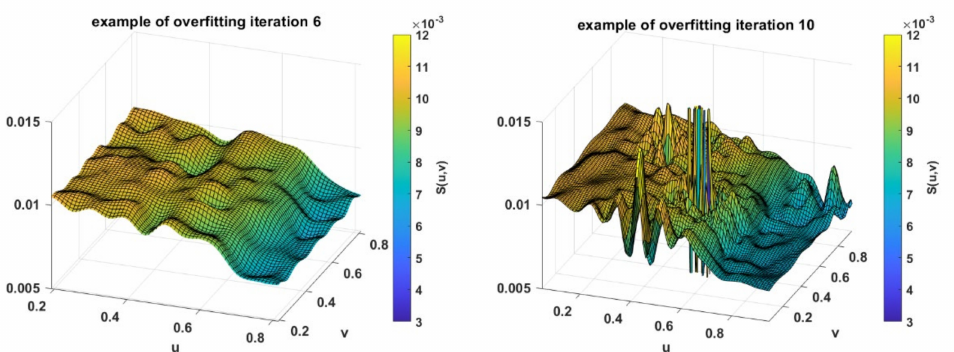
Figure 11. Two examples of overfitting -fitting of the noise of the point cloud- in the approximation for an arbitrary smoothed surface in the parametric domain. Right: after 10 iterations; left: after 6